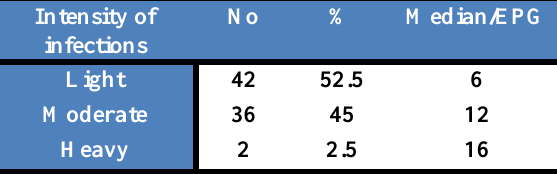
Table, 5: Intensity of hookworm infections. Intensity of No % Median/EPG infections Light